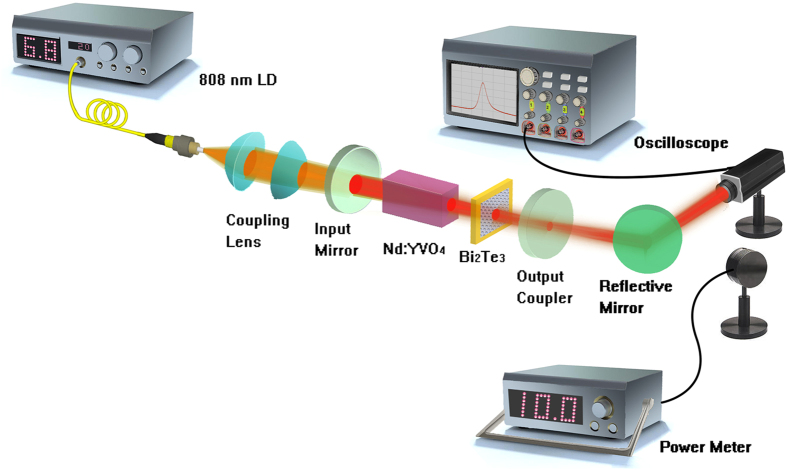
Setup of the passively Q-switched Nd:YVO4 laser at 1.0 and 1.3 μm with Bi2Te3 as saturable absorber.